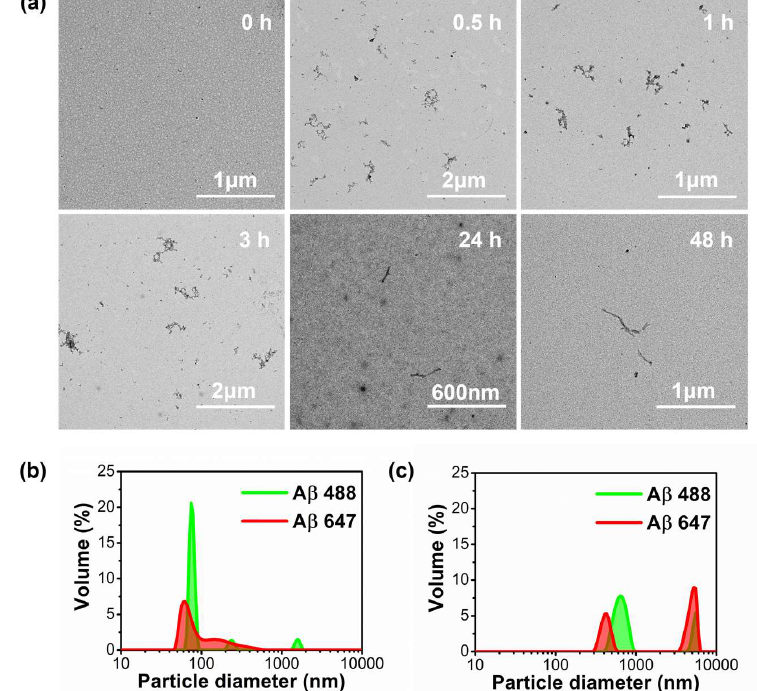
Figure 3. ( a ) Transmission electron microscopy (TEM) images of fluorescently labeled Aβ aggregates and fibers (equimolar 0.5 μM mixture of Aβ-488 and Aβ-647) at different incubation times. ( b ) and ( c ) dynamic light scattering (DLS) images of labeled Aβ peptides (Aβ-488: green line and Aβ-647: red line) formed at 0 h ( b ) and 0.3 h ( c ) of the incubation process, sonicated in a quartz cuvette in an NH 3 solution (pH 12) to avoid their aggregation ( b ) and in a phosphate buffered saline solution pH 7.4 after 20 min of aggregation ( c ). Int. J. Mol. Sci. 2020 , 21 , x FOR PEER REVIEW